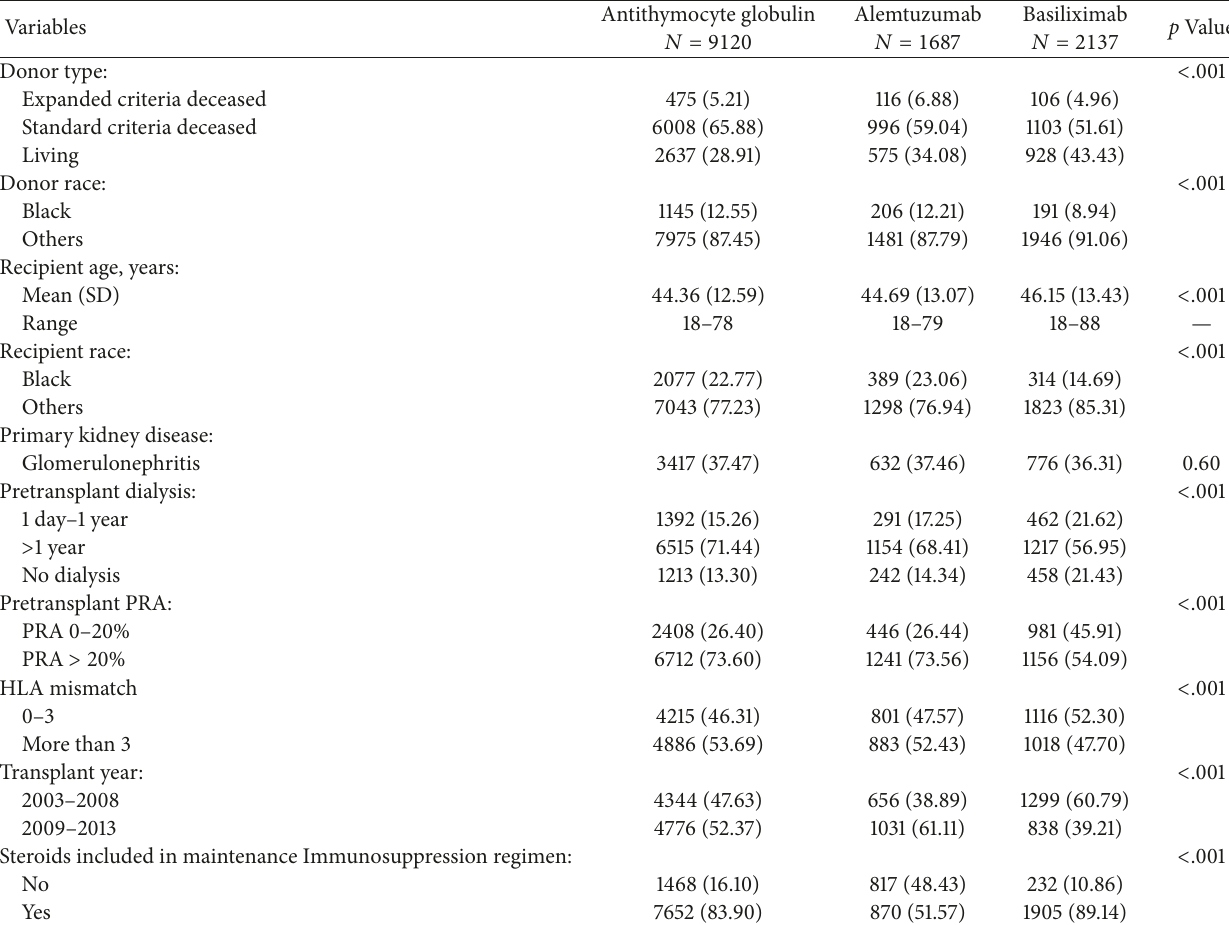
Table 1: Demographic and Clinical characteristics of adults receiving repeat kidney transplants in the United States (𝑁 = 12 , 944) from 2003 through